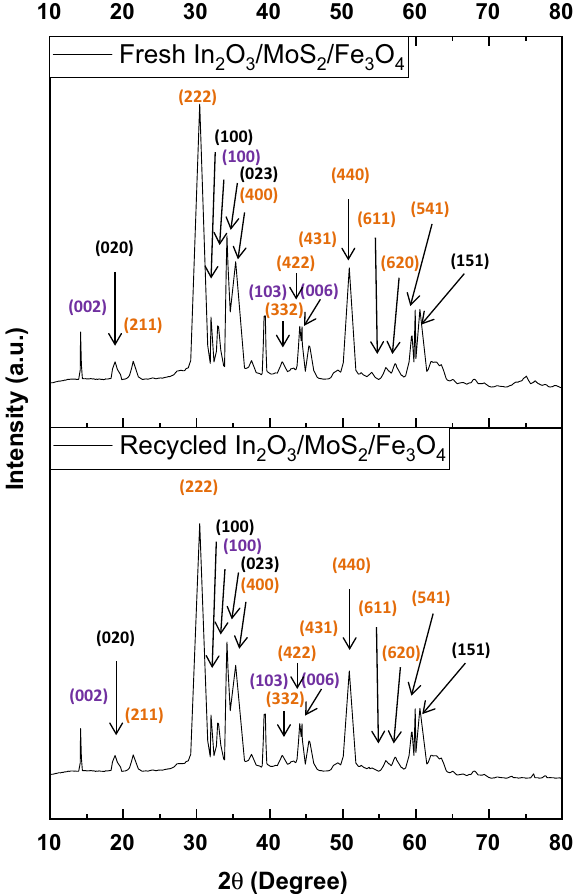
Figure 10. XRD pattern for fresh and recycled In 2 O 3 /MoS 2 /Fe 3 O 4